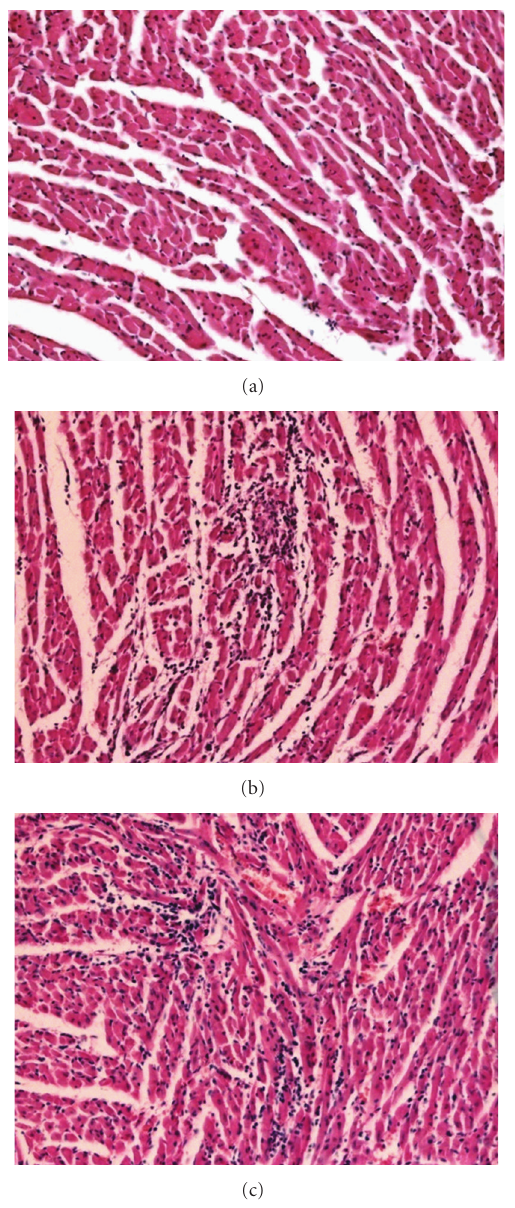
Figure 3: Cardiac tissue histology of mice infected whit T. cruzi strains. Mice infected with 1 × 10 4 parasites were sacrificed at day 21 post infection and heart was recovered. Tissue was fixed in 4% paraformaldehyde and embedded in para ffi n. Five μ m sections were Hemotoxilin-Eosin stained and observed at 20 × in optical microscope. (a) Control noninfected mice, (b) Mice infected with Ninoa strain, and (c) Mice infected with Qro strain.